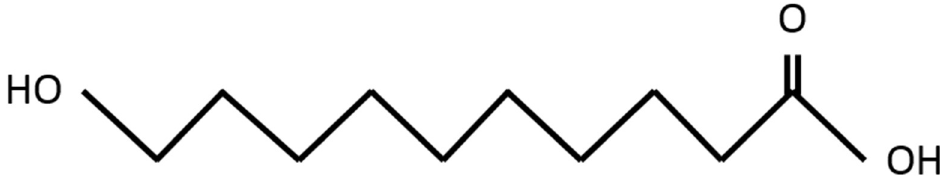
Figure 1. Structure of 10-HAD.